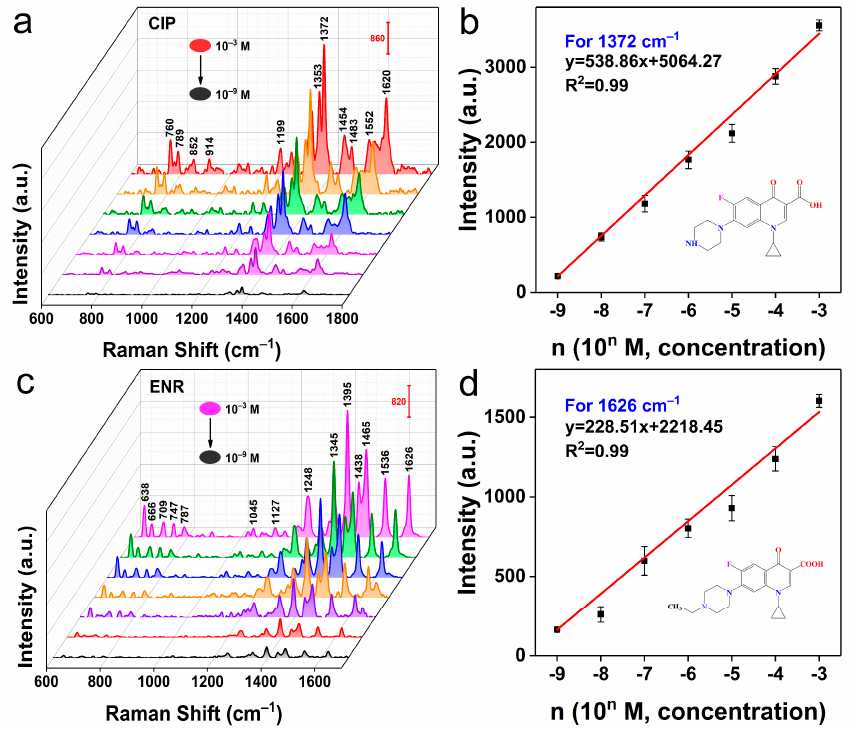
Figure 5. ( a ) SERS spectra of CIP at varying concentrations from 10 − 3 M to 10 − 9 M. ( b ) Fitting curve of SERS intensity-concentration plots for 1372 cm − 1 of CIP. ( c ) SERS spectra of ENR at varying concentrations from 10 − 3 M to 10 − 9 M. ( d ) Fitting curve of SERS intensity-concentration plots for 1626 cm − 1 of ENR.